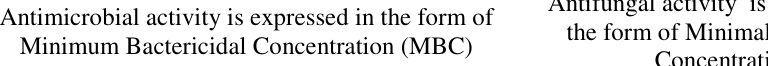
Table 2. Antibacterial activity of synthesized